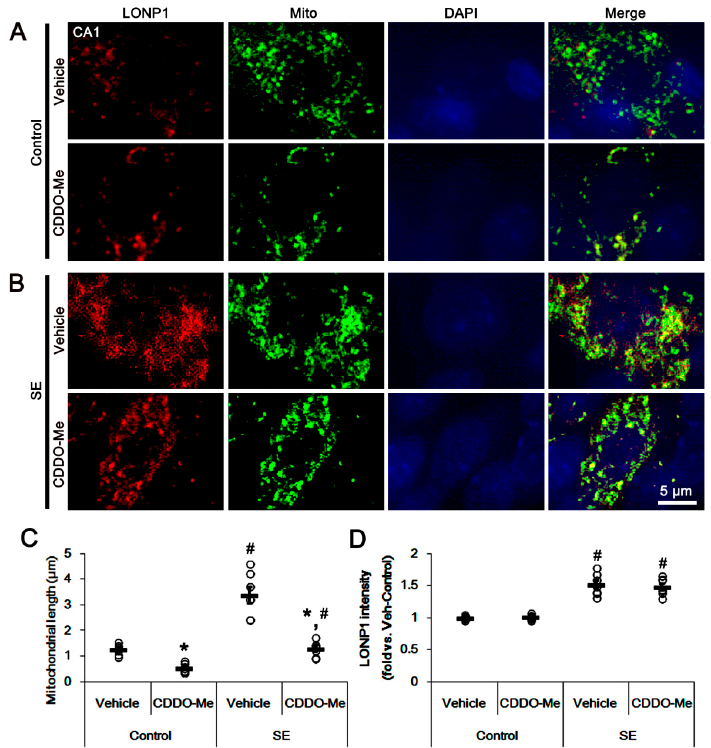
Figure 2. Effects of CDDO-Me on mitochondrial length and LONP1 expression in CA1 neurons. CDDO-Me reduces mitochondrial length in CA1 neurons of ( A ) control- and ( B ) post-SE animals. CDDO-Me does not affect the increased LONP1 expression following SE. ( A , B ) Representative photos of LONP1, mitochondria (Mito) and nuclei (DAPI) in CA1 neurons. ( C , D ) Quantifications of ( C ) the mitochondrial length and ( D ) LONP1 fluorescent intensity in CA1 neurons. Open circles indicate each individual value. Horizontal bars indicate mean value. Error bars indicate SEM (*, # p < 0.05 vs. vehicle and control animals, respectively; n = 7, respectively).